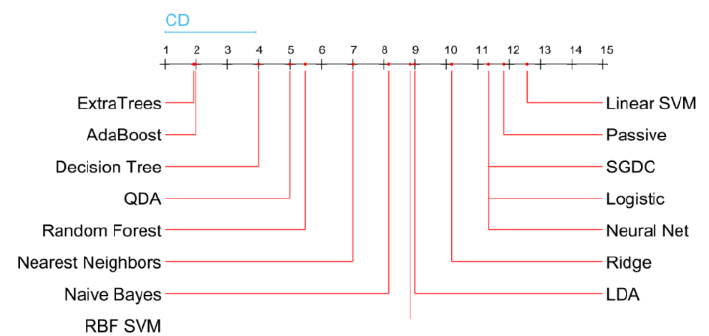
Figure Figure 5. Critical difference diagram of the final-stage classifiers (meta-learners) based on their per- formances.